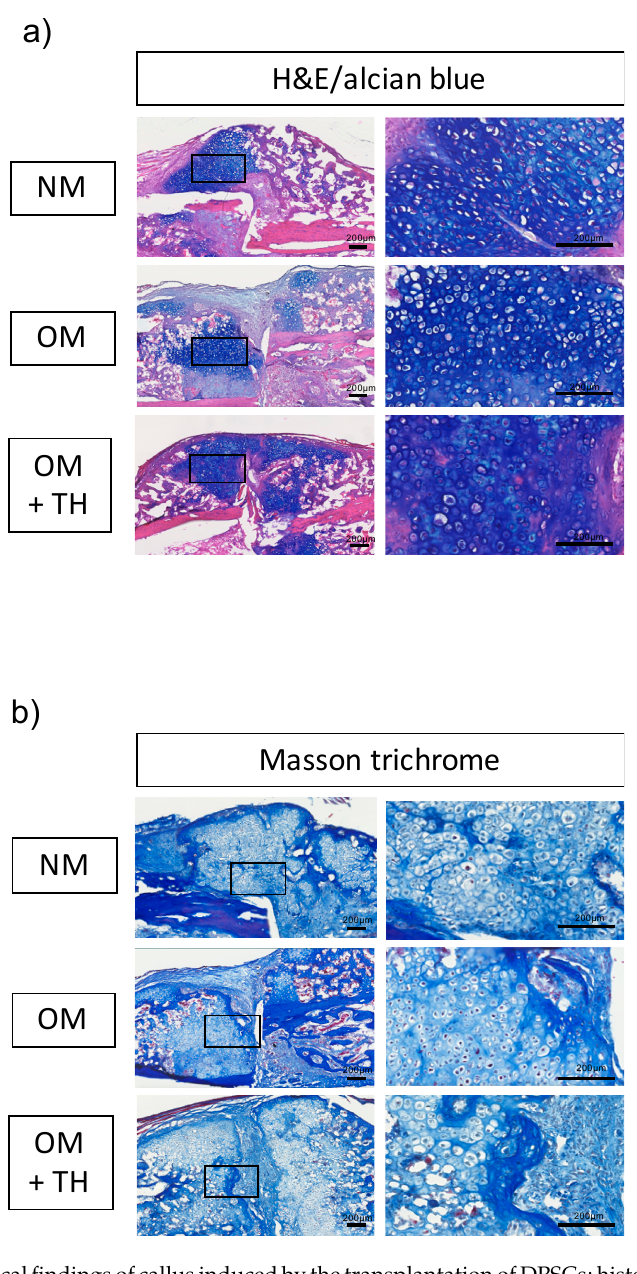
Figure 3. Histological findings of callus induced by the transplantation of DPSCs; histological findings of fractured tibiae transplanted with DPSCs cultured in NM or OM with or without TH. ( a ) representative images of hematoxylin and eosin (H&E) and alcian blue double staining of callus sections of mouse fractured tibiae 14 days after transplantation of DPSCs cultured in NM or OM with or without TH (10 − 6 M). Bars, 200 µ m. ( b ) representative images of Masson’s trichrome staining of callus sections of mouse fractured tibiae 14 days after transplantation of DPSCs cultured in NM or OM with or without TH (1 × 10 − 6 M). Bars, 200 µ m. High-magnification images of the outlined areas in the left photographs of A and B are shown in the right photographs.